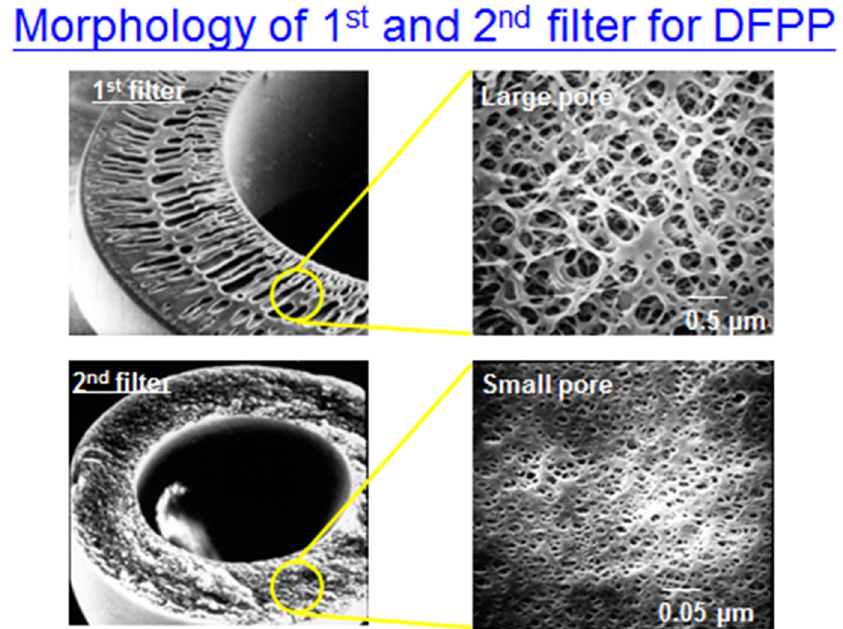
Figure A4. The morphology of 1st filter and 2nd filter (1st filter with larger pores compared to 2nd filter).